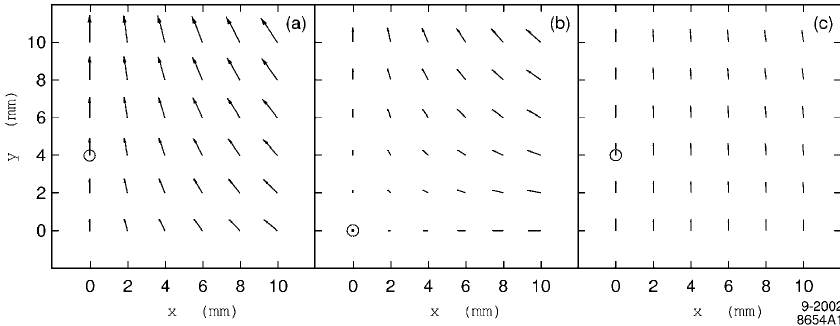
FIG. 2. Transverse wakes of elliptic bellows: (a) total, (b) quadrupolar, and (c)